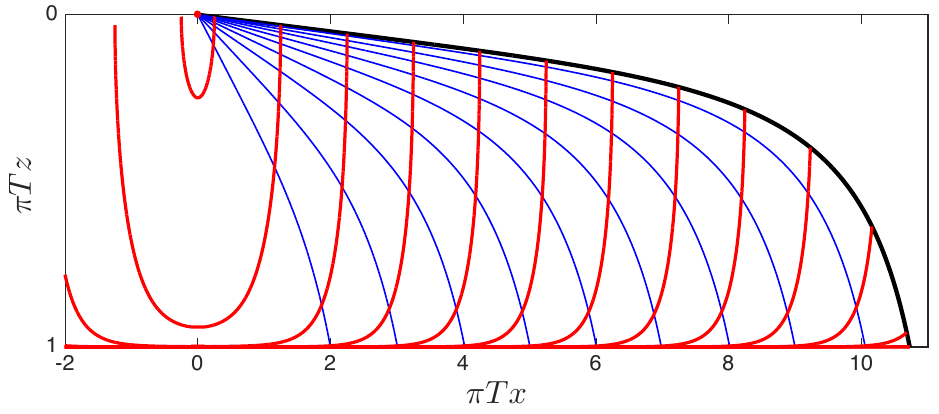
A null string (red) used to model a jet moving in the x -direction shown at several coordinate times t [143]. The string starts o(cid:11) at the point x = 0 on the boundary and expands at the speed of light while falling downwards into the holographic z -direction, towards the horizon located at z = z h = 1 = ( (cid:25)T ). The blue curves represent the null geodesics that each (red) bit of energy that makes up the string follows; the black curve is the endpoint trajectory. Di(cid:11)erent blue curves are parametrized by di(cid:11)erent values of (cid:27) , where (cid:27) is the initial downward angle in the ( x; z ) plane. The endpoint is the trajectory with (cid:27) = (cid:27) 0 ; the (cid:12)gure is drawn with (cid:27) 0 = 0 : 025. If the string were in vacuum, there would be no horizon, the blue null geodesics would all be straight lines, and the red string would maintain its initially semi-circular shape forever [128]. The opening angle of the jet which such a vacuum string represents is proportional to (cid:27) 0 . Due to the presence of the horizon, which is to say due to the presence of the strongly coupled plasma, a blue (or black) trajectory with a given (cid:27) curves downward: its angle in the ( x; z ) plane, which starts out equal to (cid:27) , steadily increases. Consequently, the opening angle of a jet increases as it propagates through the plasma [143]. The energy lost from the jet to the plasma corresponds to energy density along the string traveling along blue geodesics falling into the horizon. Clearly, geodesics with smaller (cid:27) , i.e. with smaller initial angle, propagate the farther before reaching the horizon. The thermalization length of the jet, x therm , is the distance that the endpoint travels before it reaches the horizon. It is apparent from the (cid:12)gure that jets with a smaller (cid:27) 0 , meaning a narrower initial opening angle, lose their energy more slowly and have a longer x therm [143]. Figure adapted from ref.